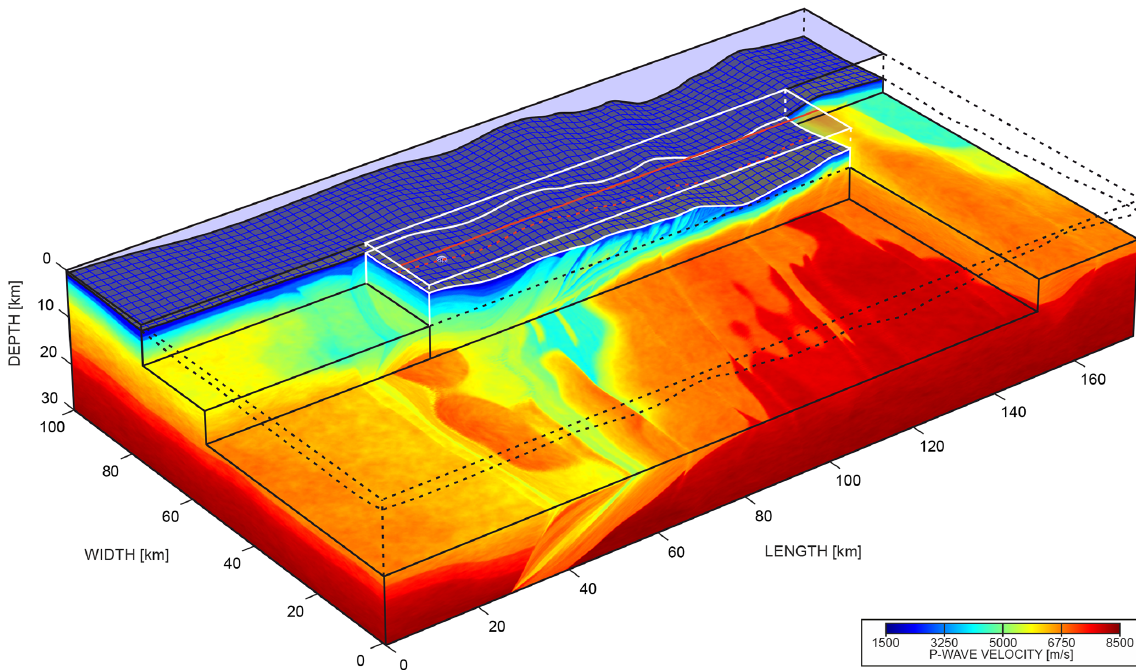
Figure 9. The perspective view on the chair plot of the 3D V p cube. The central volume defined by the white lines corresponds to the part of the model (100km × 20km × 30km) used for simulation of the data presented in Sect. 3. The white point at the seabed marks the OBS position and the red solid and dashed lines denote the shooting profile and its projection to the bathymetry